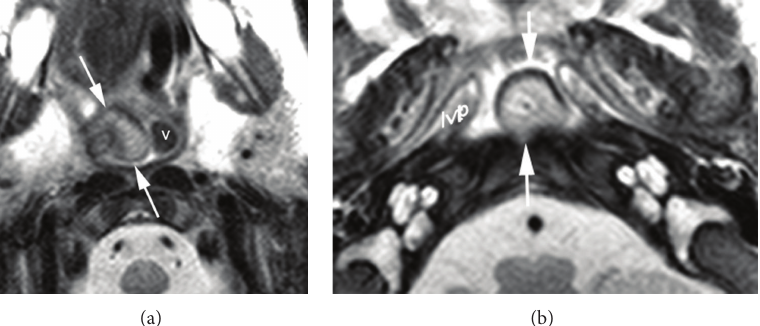
Figure 2: Axial T2-weighted image (a) at the level of the epiglottis displays that the lesion is arising from the right wall of the pharynx. The right vallecula is effaced. The left vallecula (v) is normal. Axial T2-weighted image (b) at the level of the nasopharynx shows the unattached margins of the mass (arrows). The black contour of the anterior wall of the lesion is due to chemical shift artifact, confirming the fat content of the lesion. Lvp: levator veli palatini